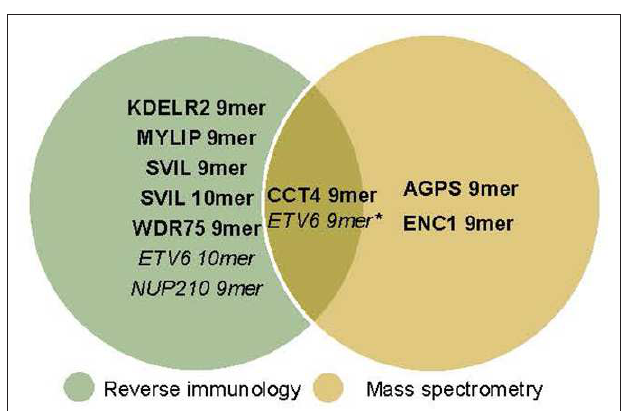
FIGURE 5 | Neoepitopes detected by reverse immunology vs. mass spectrometry. With reverse immunology TIL reactivity against 5/181 ( KADA ) and 3/49 ( ANRU ) of the predicted neoepitopes were observed. With mass spectrometry 3/136 ( KADA , not all peptides could be analyzed) and 1*/38 ( ANRU , not all peptides could be analyzed) of the predicted neoepitopes were detected on the cell surface. KADA epitopes are in Bold, ANRU epitopes are in Italic. *Detected after IFN γ treatment of the